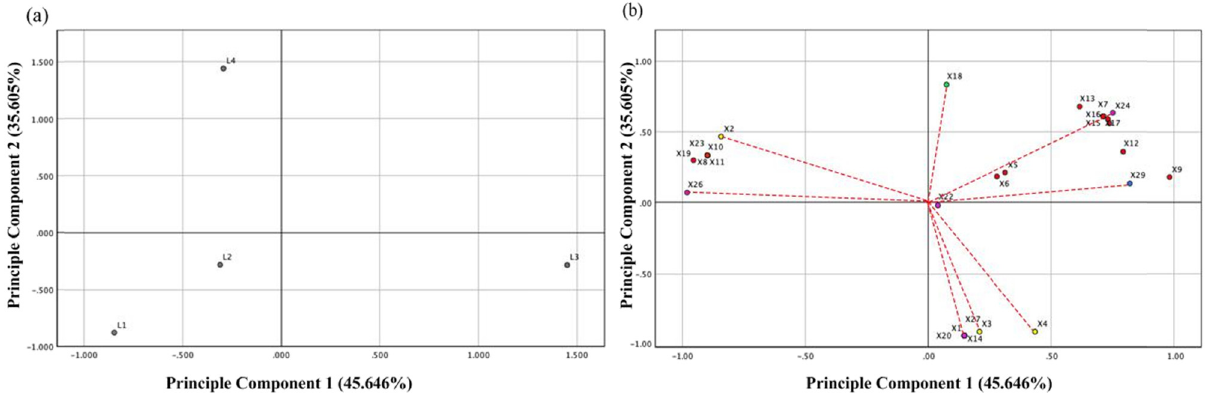
Figure 4: PCA. Score plot ( a ) and loading plot ( b ) of PC1 and PC2, from volatile compound in the L1, L2, L3, and L4. Di ff erent colored dots represent di ff erent kinds of compounds: yellow ( alcohols ) , red ( esters ) , green ( acids ) , blue ( hydrocarbons ) , and purple ( carbonyl compounds )